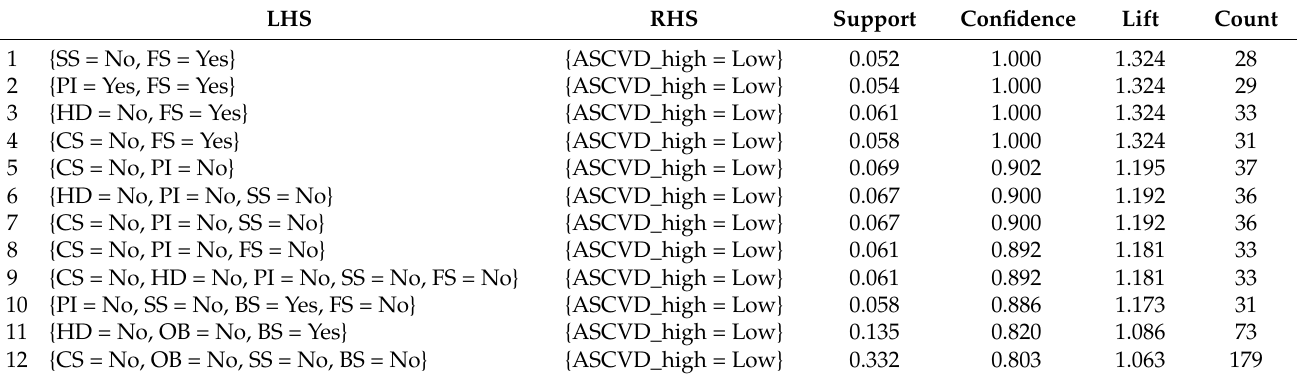
Figure 1. Association plot for male cancer survivors. Footnote: CS, current smoking; HD, heavy drinking; PI, physical inactivity; OB, obesity; SS, Suboptimal sleep; BR_S, breakfast skipping; FS, frequent snacking; ASCVD, atherosclerotic cardiovascular disease. Table 4. Results of a priori algorithms of for ASCVD score in female cancer survivors.